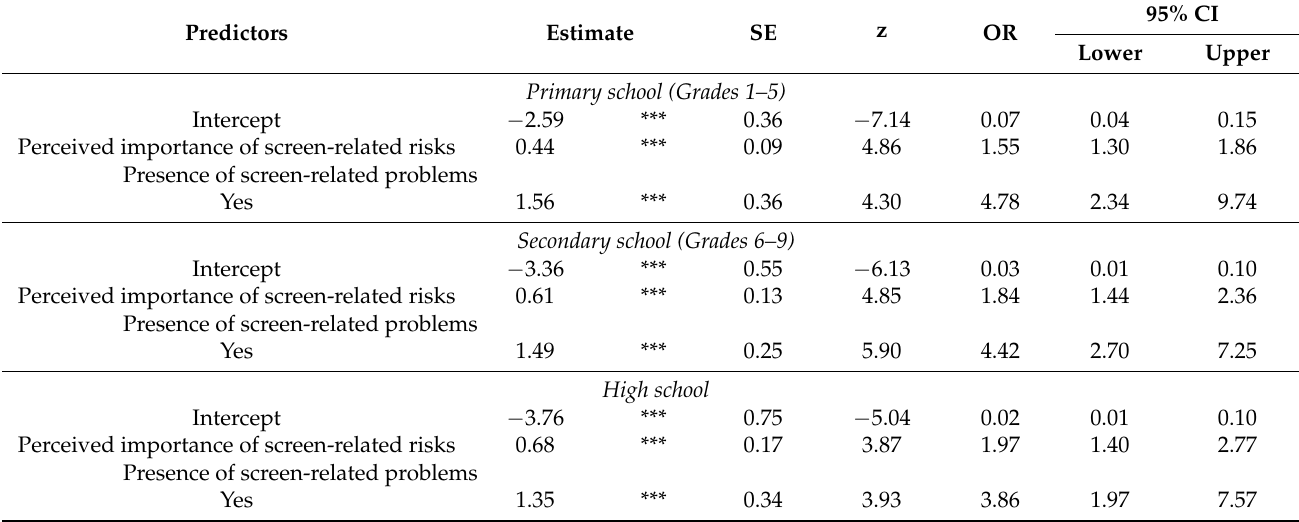
Table 4. Results of binominal logistic regression model predicting the conducting of prevention intervention(s) aimed at screen-related risk behaviors in primary (n = 1068), secondary (n = 934), and high schools (n =